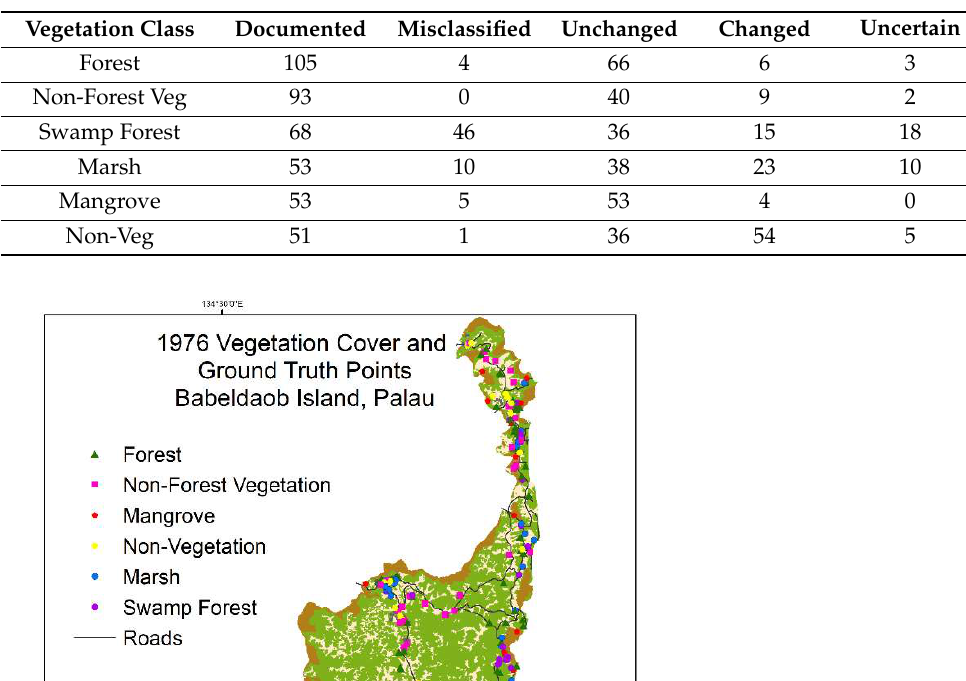
Table 1. Ground-truth points visited by vegetation cover class in 2012 on Babeldaob Island, Palau, with observations related to the cover classifications in the 1976 vegetation survey [26].